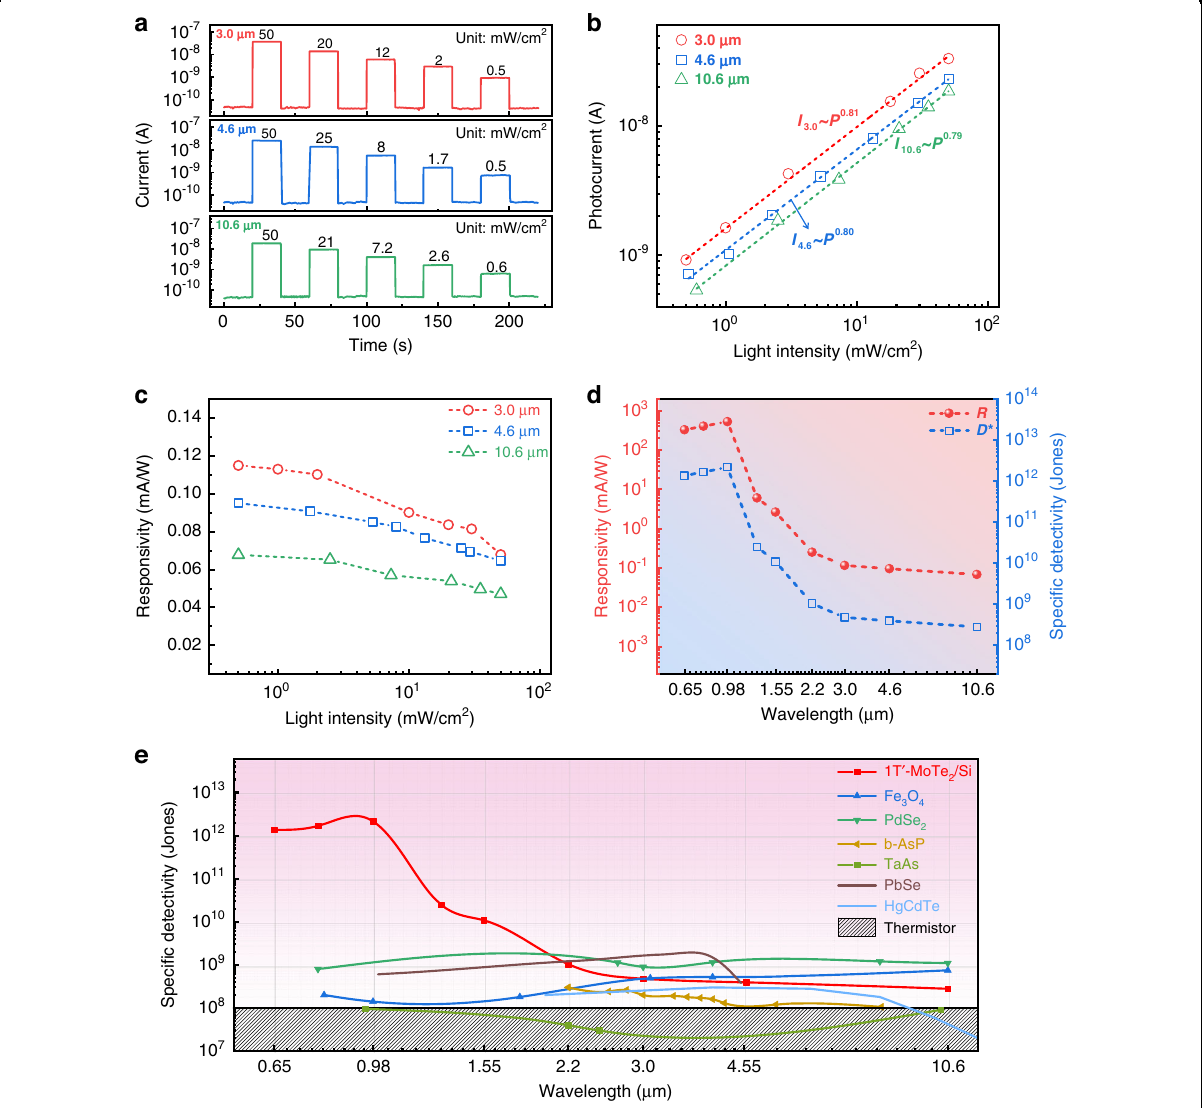
Fig. 4 MIR photodetection performance of the photodetector. a Temporal photoresponses of the Gr/1T ʹ -MoTe 2 /Si Schottky junction device under light illumination of 3, 4.6, and 10.6 μ m with various light intensities. b The fi tting photocurrent versus light intensity at 3.0, 4.6, and 10.6 μ m by the power law. c Responsivity at 3.0, 4.6, and 10.6 μ m as a function of light intensity. d Responsivity and speci fi c detectivity of the photodetector over a broad spectral range. e Comparison of the room temperature speci fi c detectivity of the Gr/1T ʹ -MoTe 2 /Si Schottky junction device with other IR